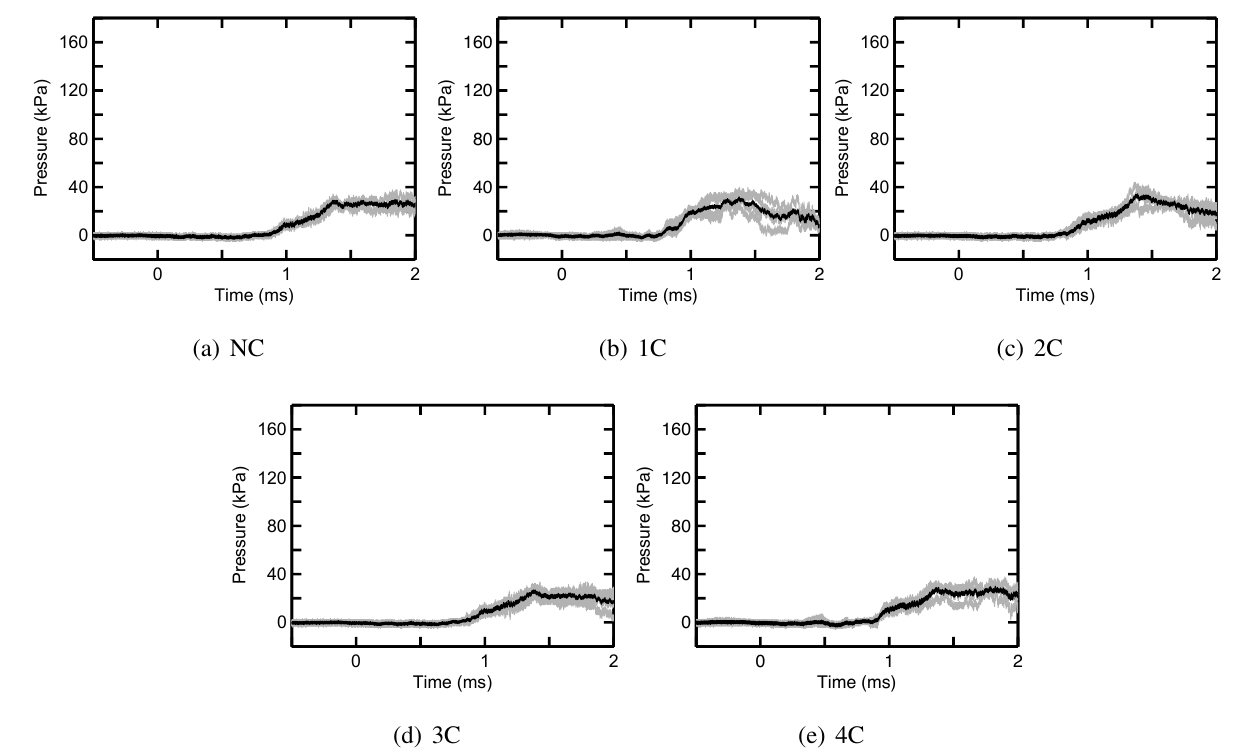
Figure 15. Open cell foam pressure recordings for all cases: transmitted